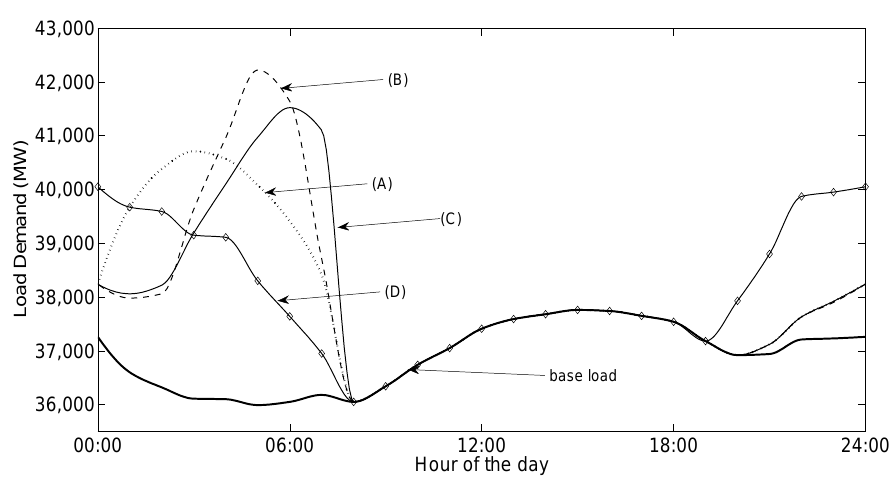
Figure 19. ERCOT June